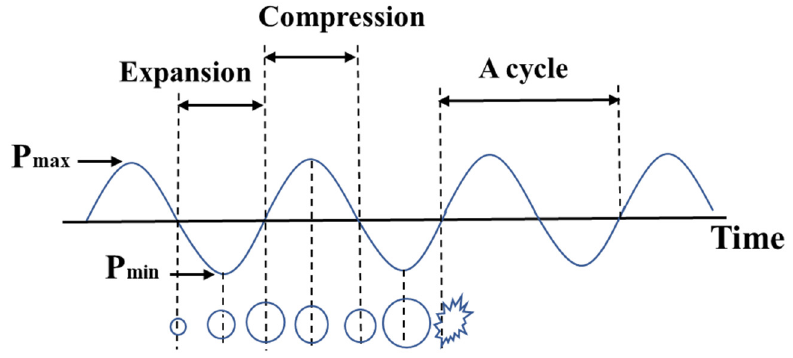
Figure 2. Cavitation effect process of ultrasonic wave